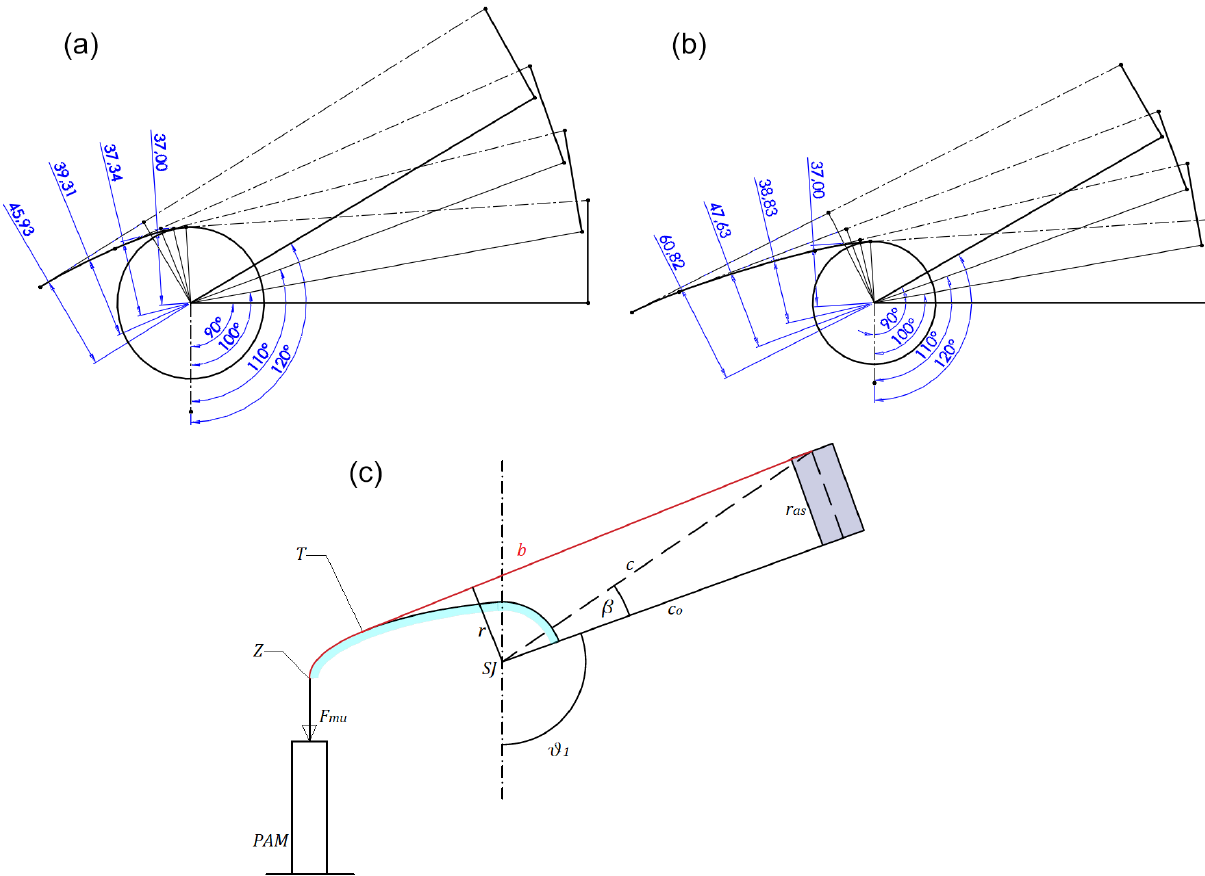
Figure 4. Cam profile design obtained by graphical approach: by using DMSP-20-200N muscle (a) , and DMSP-10-100N mus- cle (b) . (c) Drawing of cam implementation in the